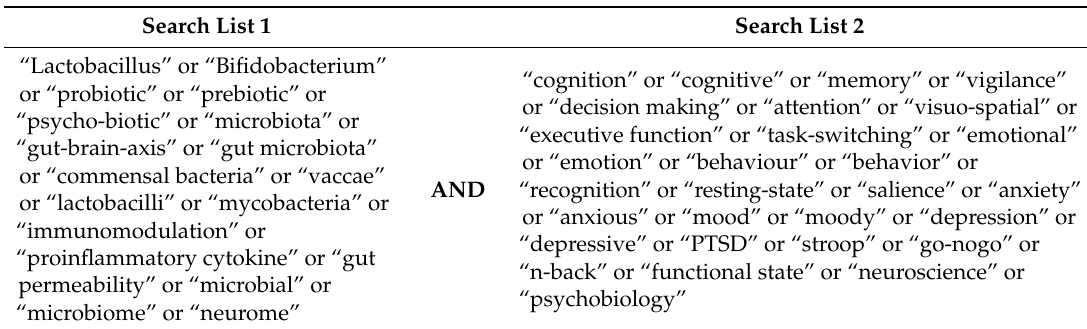
Table 1. Search list items for literature